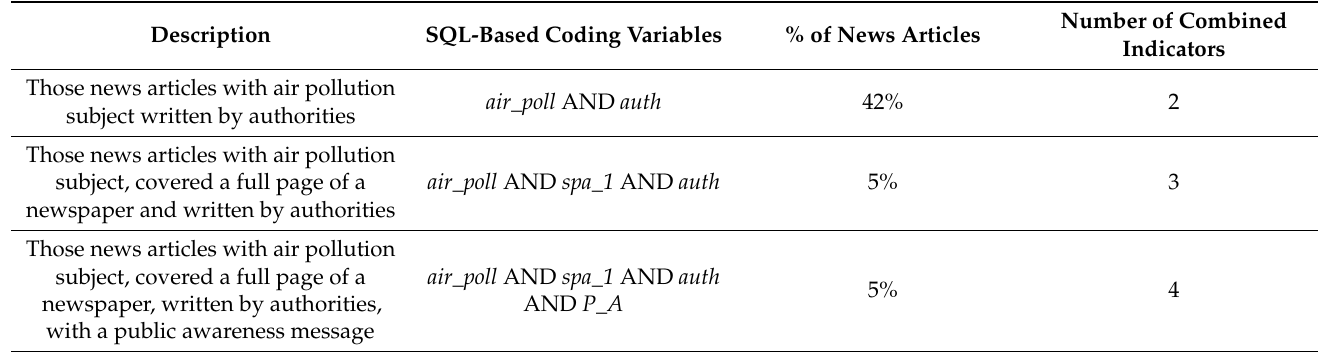
Table 2. A few representatives of the crossing of two or more